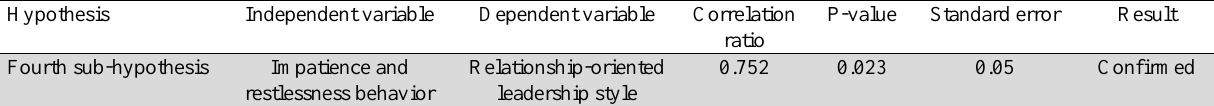
The summary of Spearman correlation for testing the fourth